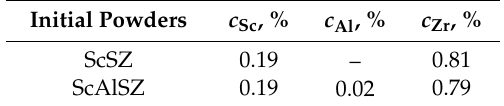
Table 1. Atomic ratios of Sc, Al, and Zr in the initial